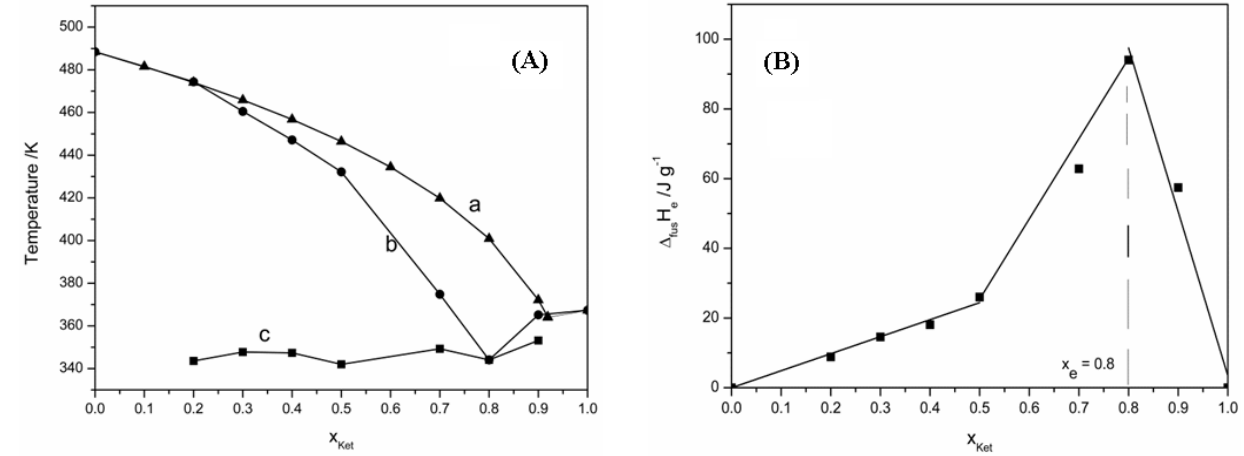
Figure 6. ( A ). Phase diagram of binary mixture Ket—D-HCl: a. ideal behavior; b. real behavior; c. eutectic temperature. ( B ) Tammann’s plot.